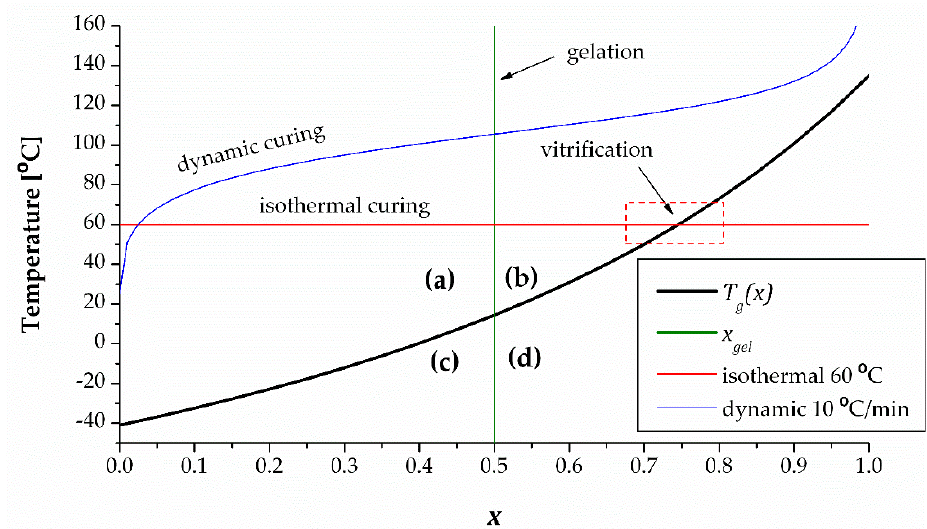
Figure 4. Conversion-temperature-transformation (CTT) diagram for a DGEBA-diethylenetriamine system, produced from the data reported in the literature [46].